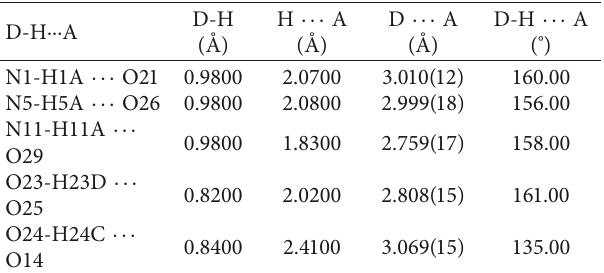
Table 4: Hydrogen-bonding geometry of LISZn2